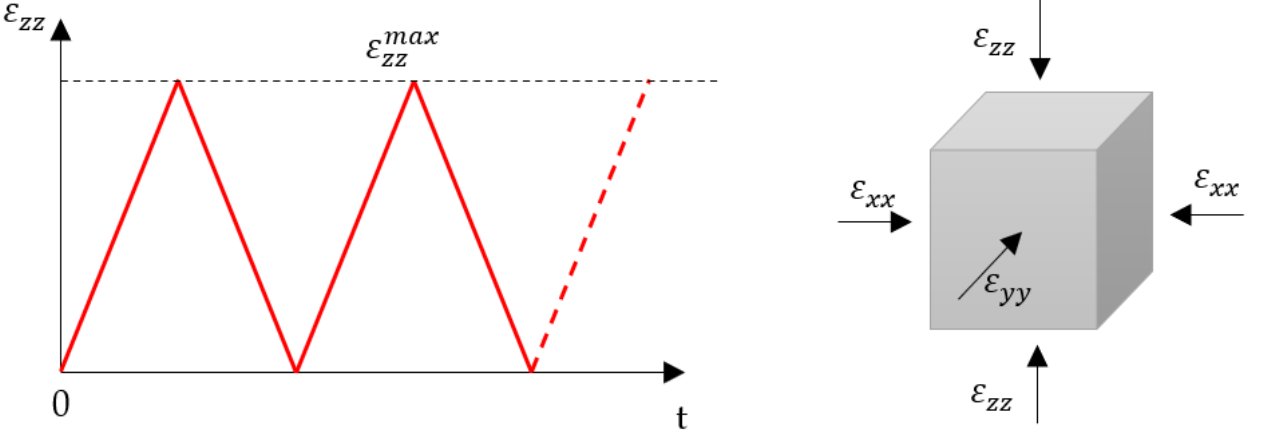
Figure 5. One-way strain-controlled input for cyclic triaxial testing.